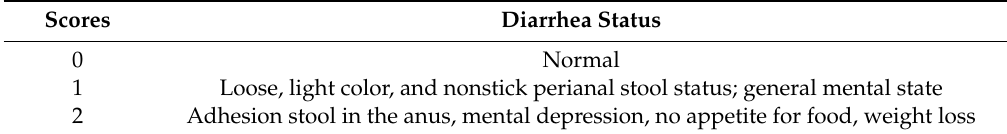
Figure 2. Effects of WAP on total diarrhea status scores ( A ), weight increment ( B ), the difference in water consumption ( C ). C, control group; DM, antibiotic-associated diarrhea group; NR, natural recovery group; and WAP, Astragalus polysaccharide group. Data are expressed as means ± S.D. ( n = 6).